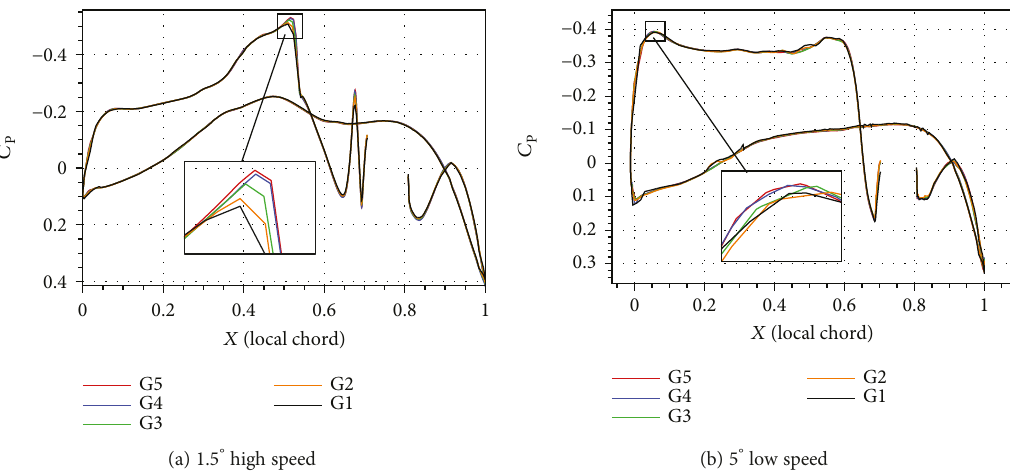
Figure 9: Surface pressure distribution of the airframe for the powered con fi gurations on the engine symmetry plane of the fi ve levels of grids at 1.5 ° (high speed) and 5 ° (low